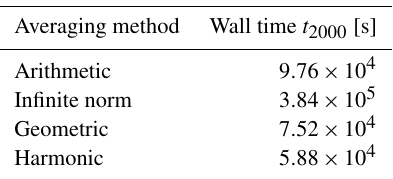
Table A2. Wall time for time step 2000 of the self-consistent sub- duction benchmark for different viscosity averaging methods using 28